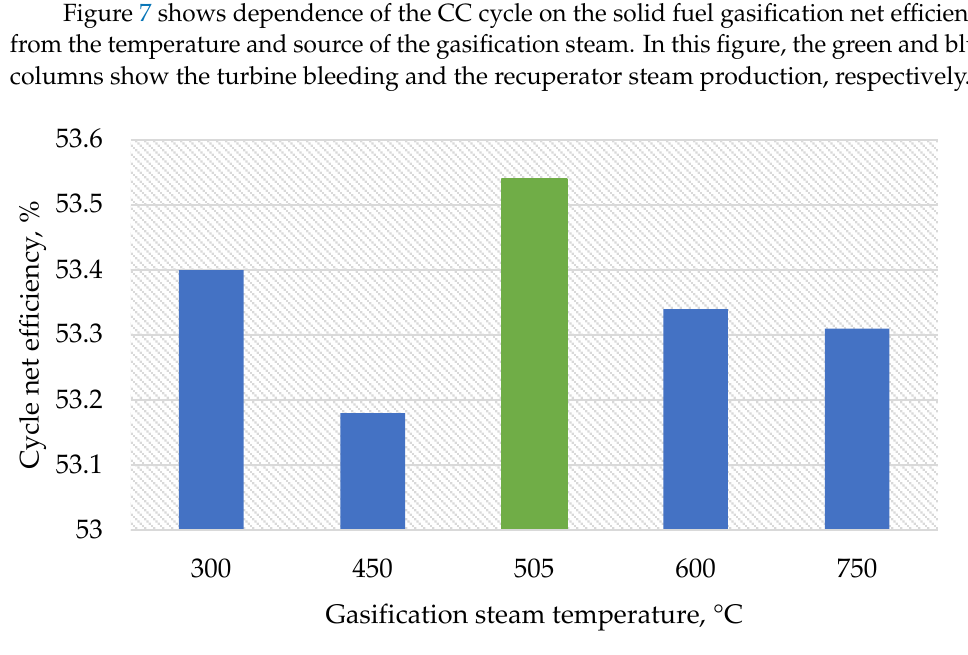
Figure 8. Power structure of the cycle with gasification steam bleeding from the turbine. At optimal parameters of the gasification steam, the cycle net efficiency reaches the level of 53.54%. 4. Conclusions The described computer simulation model provides a relationship between the syn- gas contents and flow to the steam-oxygen blow parameters. The results strongly imply